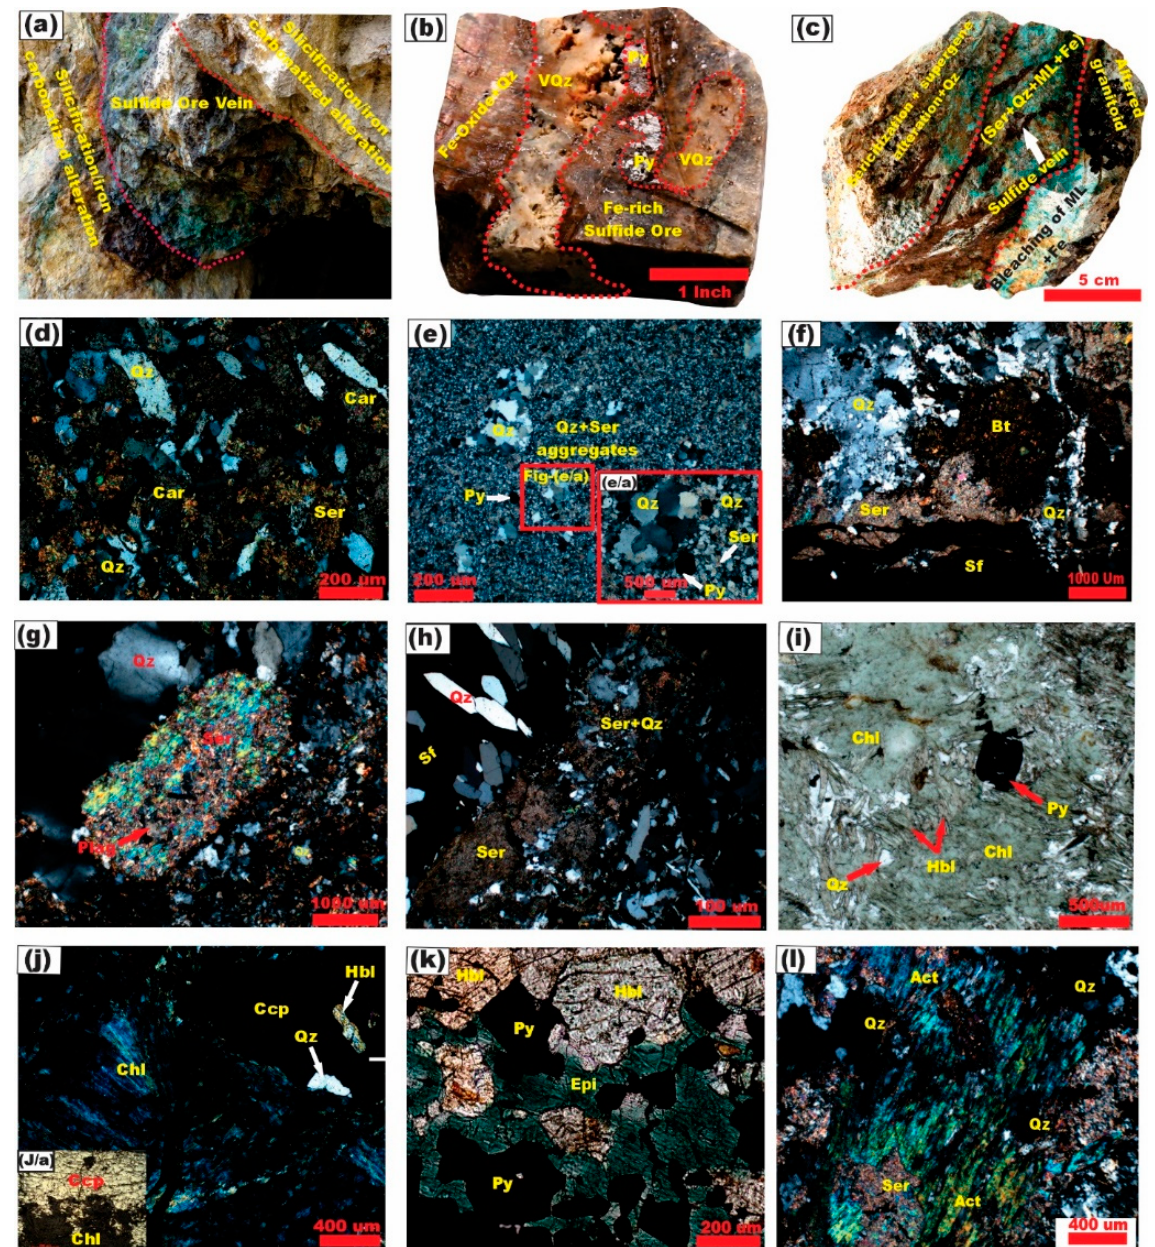
Figure 4. Outcrop photos and microphotographs (transmitted plane and cross-polarized light) of alteration types: ( a ) Silicification/iron carbonatization around the sulfide vein; ( b ) vuggy quartz is surrounded by sulfide (mainly pyrite) + iron hydroxide; ( c ) sericitization + supergene alteration at wall rock contact + within sulfide quartz vein; ( d ) brecciation of quartz and carbonate filled by sericite; ( e ) first stage of silicification enclosed the coarse-grained quartz + Py-I; (e/a) showing the high magnification microphotograph of (Figure 3e); ( f ) second stage of silicification cutting primary alteration mineral; ( g ) sericites aggregates with plagioclase pseudomorph phenocryst; ( h ) fine grain aggregates of sericite and quartz cutting early formed euhedral quartz and sulfide; ( i ) chlorite replacing prismatic hornblende, and euhedral Py-I is enclosed within alteration zone; ( j ) chlorite is overprinted on sulfide mineral (massive chalcopyrite) in transmitted crossed-polarized light, (j/a) showing reflected plane-polarized light of same sample; ( k ) epidote replacing hornblende at sulfide bearing sheared zone, and Py-I is encrusted by these alteration mineral; ( l ) overlapping of actinolite on the sericite aggregates. Py, pyrite; Ccp, chalcopyrite; Fe, iron; Qz, quartz; ML, malachite; Ser, sericite; Bt, biotite; Sf, sulfide ore; Plag, plagioclase; Chl, chlorite; Hbl, hornblende; Epi,epidote; Act, actinolite; Car, carbonate; VQz, vuggy quartz.